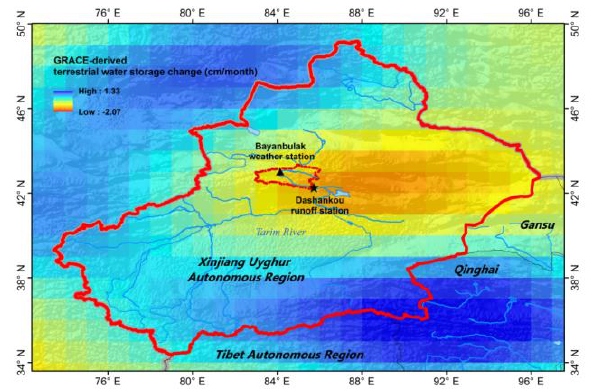
Figure 3. Changing rates of terrestrial water storage (cm/month)